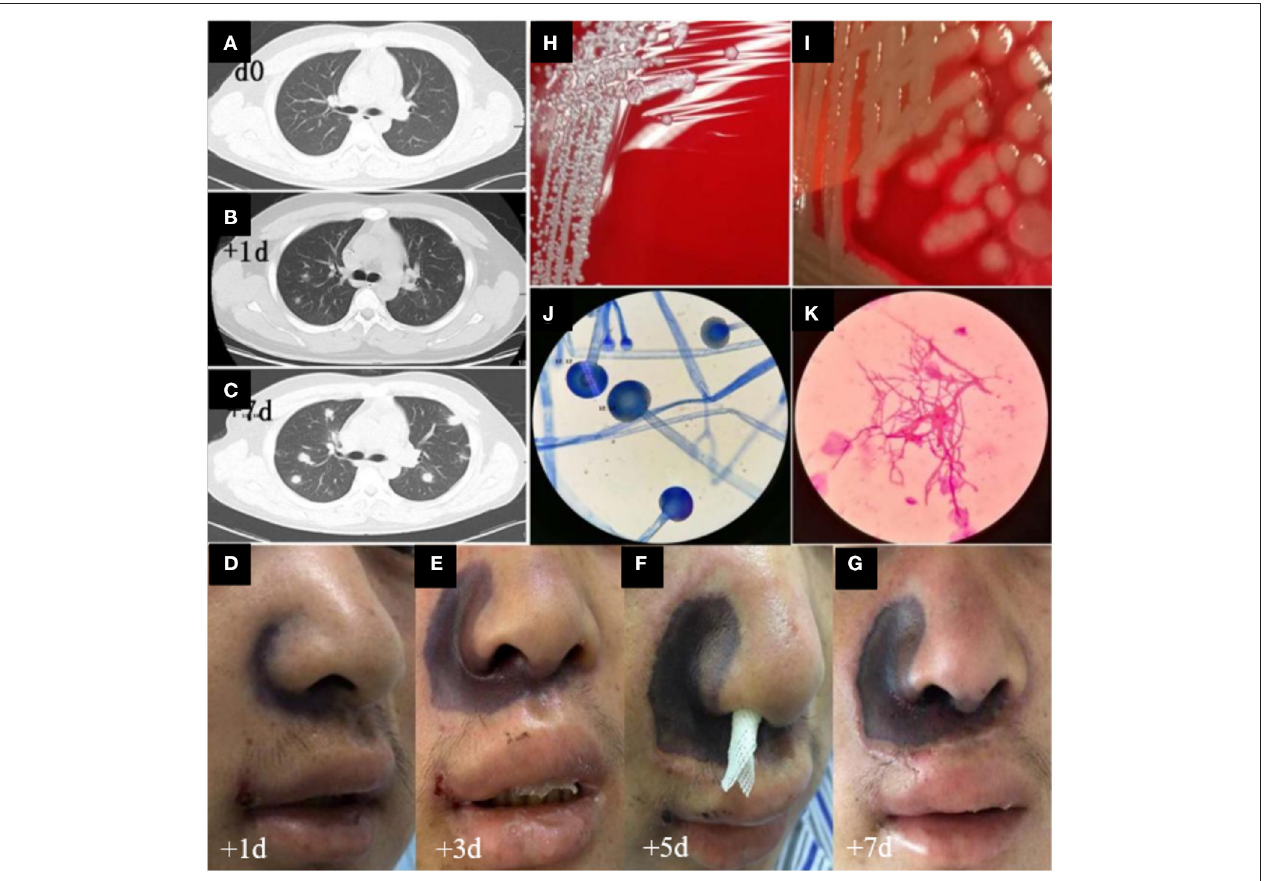
FIGURE 2 | CT images, advancement of skin damage, and morphologic features of microbiological cultures in this case. (A–C) Day 0, day 1, and day 7 of the chest CT images, respectively. (D–G) Day 1, 3, 5, and 7 images of the nasal skin, respectively. (H,I) Bacterial cultures of Staphylococcus haemolyticus and MDR Pseudomonas aeruginosa , respectively. (J,K) The morphologic features of